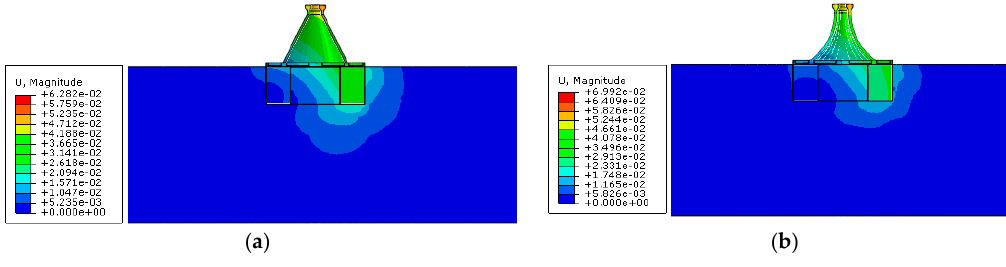
Figure 8. Equivalent plastic strain under ultimate load: ( a ) Line type; ( b ) Arc type.